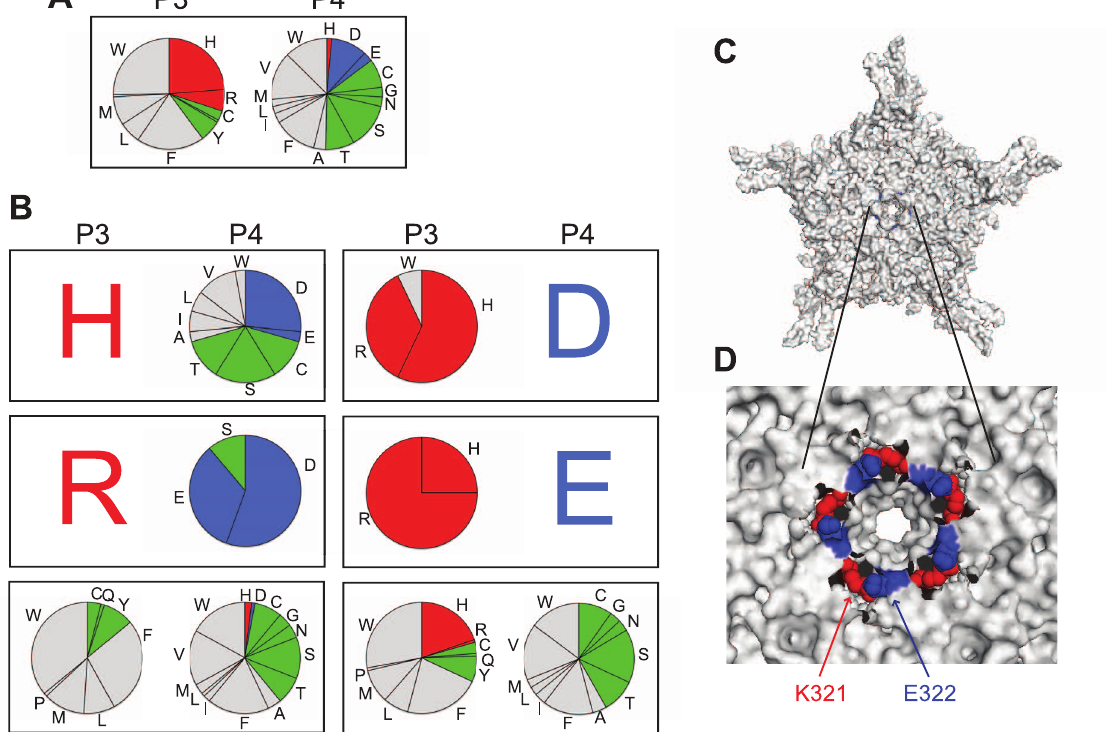
Figure 4. Peculiar positive-negative and neutral-neutral amino acid combinations at P3 and P4 in the 143 viable VP heptapeptides. ( A ) Amino acid compositions of all the 143 viable VP heptapeptide mutants. ( B ) Various amino acid combinations at P3 and P4 positions in the viable VP heptapeptide mutants. Left panels show P3/P4 combinations when histidine (H, upper left), arginine (R, middle left) or a non-charged amino acid (lower left) is at P3. Right panels show P3/P4 combinations when aspartic acid (D, upper right), glutamic acid (E, middle right) or a non-charged amino acid (lower right) is at P4. ( C ) Topological location of amino acid residues at P3 (K321, red) and P4 (E322, blue) in the wild type AAV2 capsid VP3 is shown on a VP3 pentamer viewed down an icosahedral five-fold symmetry axis at the center. E322 is partially exposed on the outer surface near the five-fold pore while K321 is barely seen from the outside of the capsid. ( D ) A close-up view of K321 and E322. Ten amino acids (from V323 to I332) forming the outer ridge around the five-fold pore are removed to make K321 and E322 visible. Five pairs of K321 and E322 form a ring in the five-fold channel wall. Panels C and D are created using PyMOL. doi:10.1371/journal.pone.0066211.g004 not all, are functionally competent and represent a pool of AAP mutants that have the ability to exert their capsid assembly function.